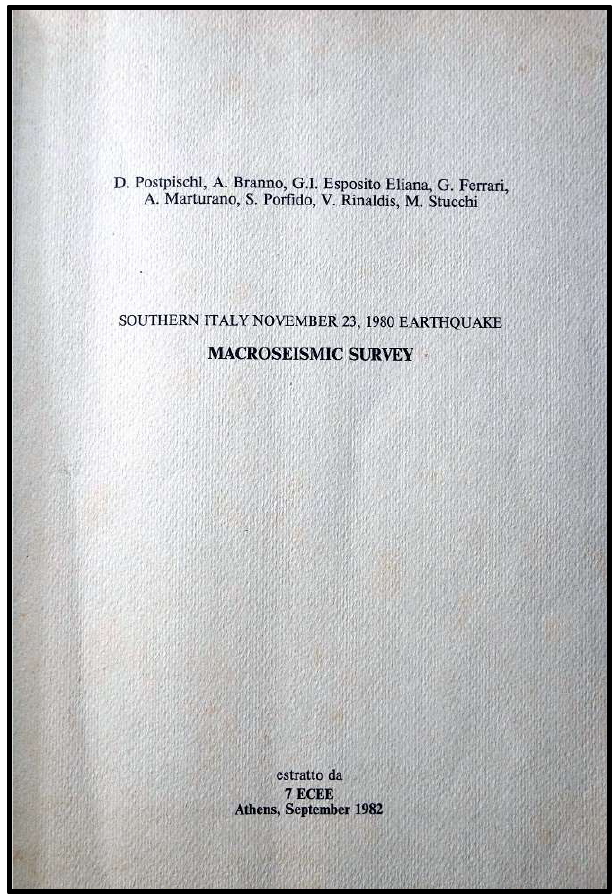
Figure 5. Macroseismic survey of the 23 November 1980 earthquake presented at the 7ECEE confer- ence in Athens in 1982 [3].